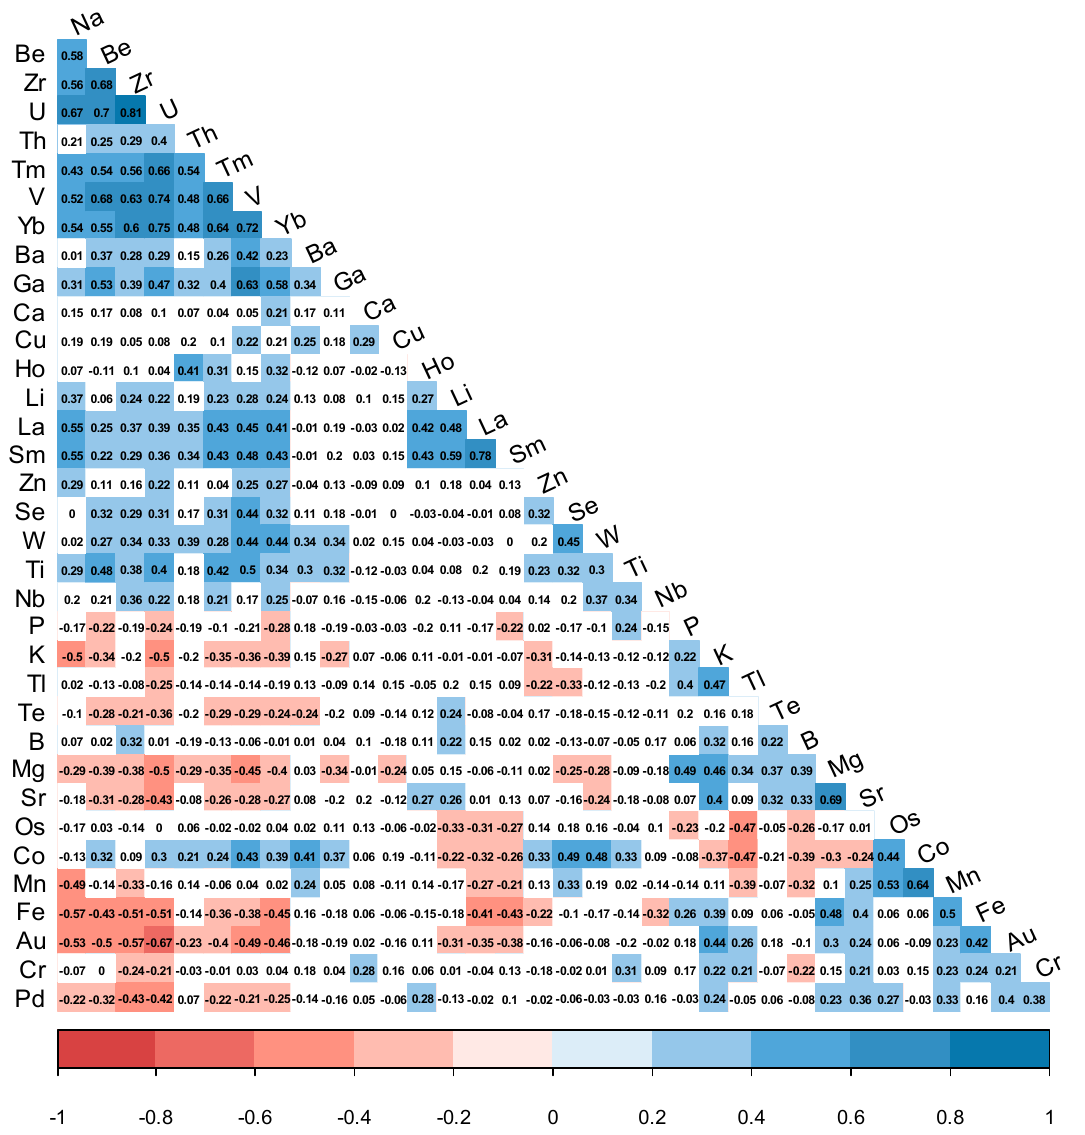
Figure 4. Correlation matrix plot for vintage year 2018, indicating the positive (with blue shading) and the negative (with red shading) correlation between metals.